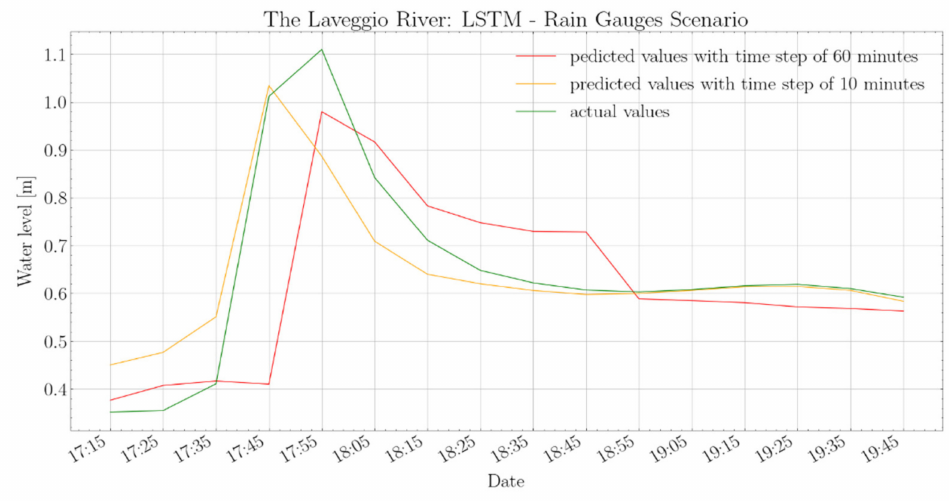
Figure 14. Performance of multivariable LSTM in the rain gauges scenario: test flood event of 4 June 2018, Laveggio River. Actual ( green ) and forecasted water levels with 60- ( red ) and 10-min ( orange ) input